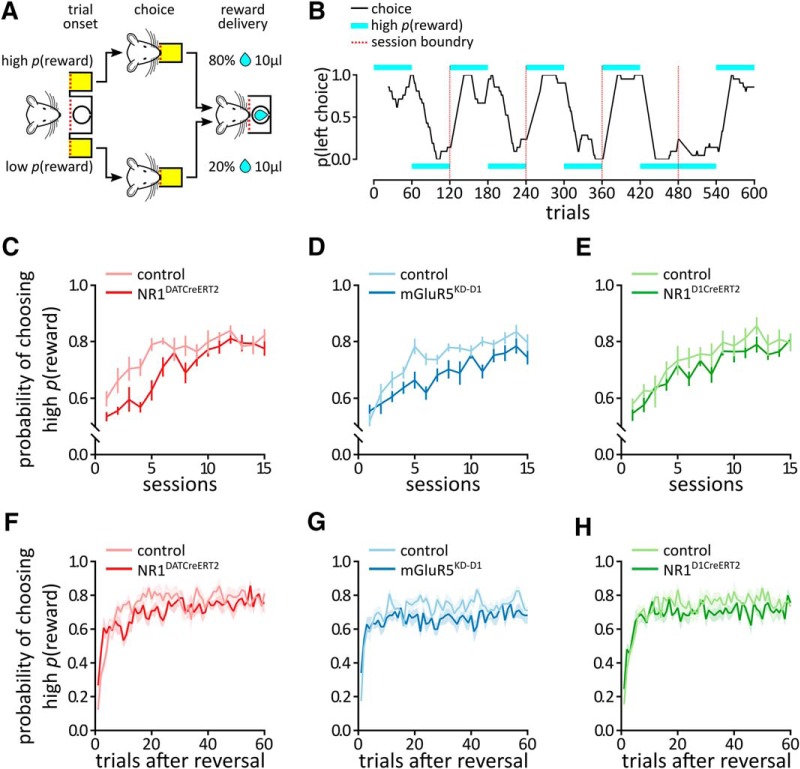
The probabilistic reinforcement learning task. A, Schematic representation of the probabilistic reinforcement learning task. The animal could make a nose-poke in one of two ports. Following a nose-poke, water could have been delivered with the probability depending on the chosen port. The nose-poke ports were randomly assigned 80% or 20% reward probabilities. During each session, the reward probabilities were reversed after 60 trials. B, An example the choice behavior of a mouse in 600 trials (sessions 6–10). The black line shows the probability of choosing the left side (data smoothed with the 21 point moving average). The cyan bars indicate the side with the higher probability of reward delivery. The red dashed line indicates session boundaries. C–H, Probability of selecting the alternative with the higher reward probability by the NR1DATCreERT2 (mutant, n = 6; control, n = 8; C, F), mGluR5KD-D1 (mutant, n = 8; control, n = 9; D, G), and NR1D1CreERT2 (mutant, n = 6; control, n = 9; E, H) strains. C–E, Session-by-session analysis; data were collapsed across trials. F–H, Trial-by-trial analysis; data were collapsed across sessions. Data are represented as the mean ± SEM.